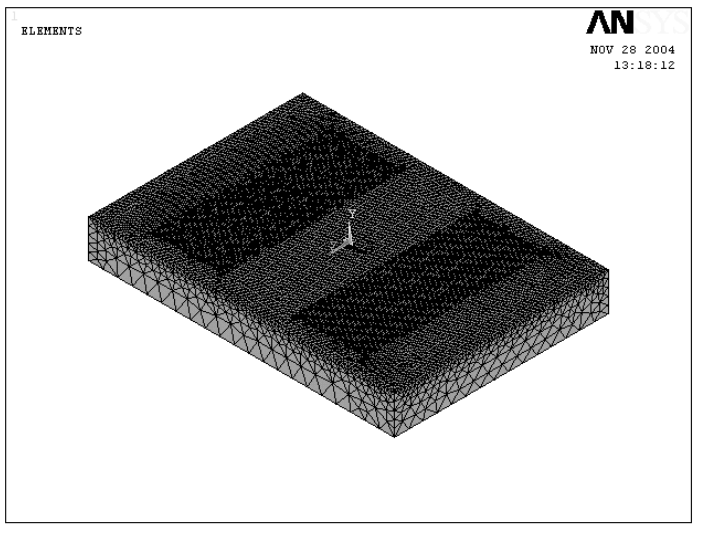
Figure 5. SAW sensor 3D FE